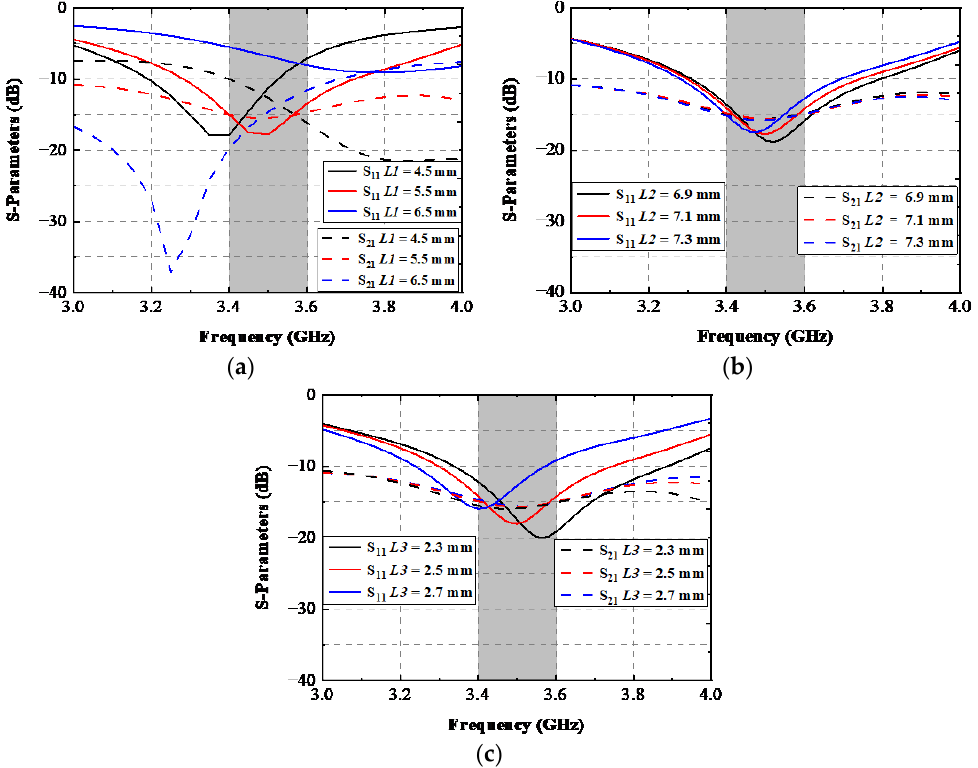
Figure 5. Simulated S-parameters with the various values of ( a ) L1 , ( b ) L2 , and ( c ) L3. The impact resulting from the ground clearance is depicted in Figure 6. Figure 6a presents the simulated S-parameters as a function of Lcl , and the normalized impedance varying with the frequency of each situation is also illustrated in Figure 6b. The direction of clockwise indicates a frequency range of 3 – 4 GHz. When the value of Lcl was 0.8 mm, the simulated resonant frequency was 3.5 GHz, and the − 6 dB bandwidth was 430 MHz (3.3 – 3.73 GHz). The impedance matching condition is not ideal enough. As shown in Figure 6b, the normalized impedance at 3.5 GHz when Lcl = 0.8 mm was 1.8393 – 0.7614 i (m1), which is far away from the center point of the Smith Chart; the mutual magnetic coupling between Ant. 1 and Ant. 2 was only larger than 10 dB within the interested band. When the value of Lcl was 1.8 mm, the designed AP still resonated at 3.5 GHz, but port impedance matching improved significantly. The − 10 dB impedance-matched band is 3.31 – 3.76 GHz, which can contain the targeted band. The magnetic coupling between two ports in an AP is superior to 15 dB. Furthermore, the normalized impedance at m1, plotted in Figure 6b, was 1.256 – 0.1135 i (m2), which improved a lot compared with m3. When the value of Lcl is 2.8 mm; an apparent shift toward the left of the resonant fre- quency could be observed from Figure 6a, and the normalized port impedance at 3.5 GHz of this time is marked as m3 in Figure 6b, which is 1.1148 – 0.468 i.